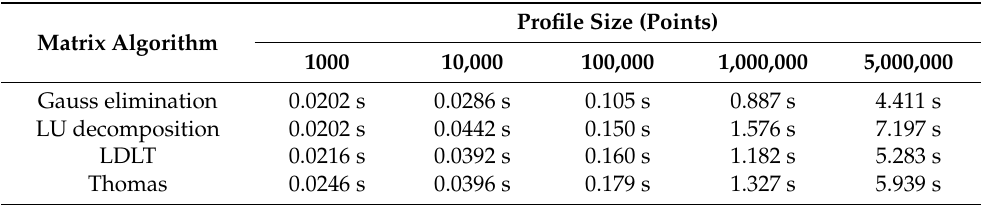
Figure 10b. The roughness parameter Ra and Rq were chosen for characterization and calculated according to the ISO 4288 [30]. The sampling length was set as 2.5 mm in this experiment, the evaluation length was 12.5 mm, and the cut-off wavelength was 2.5 mm which was numerically equivalent to the sampling length. In order to better compare the differences brought by different algorithms, four algorithms were applied to the standard cubic spline. Gaussian filter and spline filter in commercial software Mountains ® were taken as the reference in this experiment. The roughness parameter Ra, Rq were obtained as shown in Table 3. It can be calculated that the errors of parameter values Ra and parameter values Rq obtained by Gaussian filter and spline filter in the evaluation software were 0.06178% and 0.06413% respectively. This was due to the difference of filtering algorithm and transmission characteristics between the two filters. As shown in Table 4, the roughness parameter value obtained by the cubic spline filter in the software was different from the results of the cubic spline filter realized by the four algorithms. In fact, the difference was caused by the implementation algorithm of spline filter. In 2011, Mathia et al. pointed out that the calculation errors of roughness parameters after using a spline filter was bigger than using a Gaussian regression filter [31], which further proved the evaluation difference between the Gaussian filter and spline filter in the software Mountains ® . Therefore, this study takes the output value of the Gaussian filter as the final reference. Compared with the spline filter in the software, the implementation algorithm reduces the evaluation difference between the spline filter and the Gaussian filter as shown in Table 5. The roughness value obtained by the LDLT algorithm is the closest to the Gaussian filter, and the error were only 0.002667% and 0.03484%. Table 1. Time consumption results of the profile filtering test.